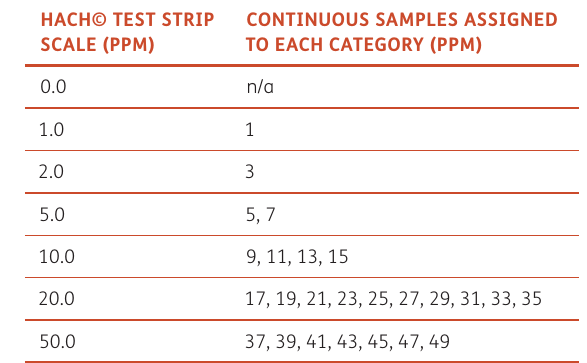
Table 3 Test strip categories used by visual volunteers and the ranges of continuous nitrate samples placed in those